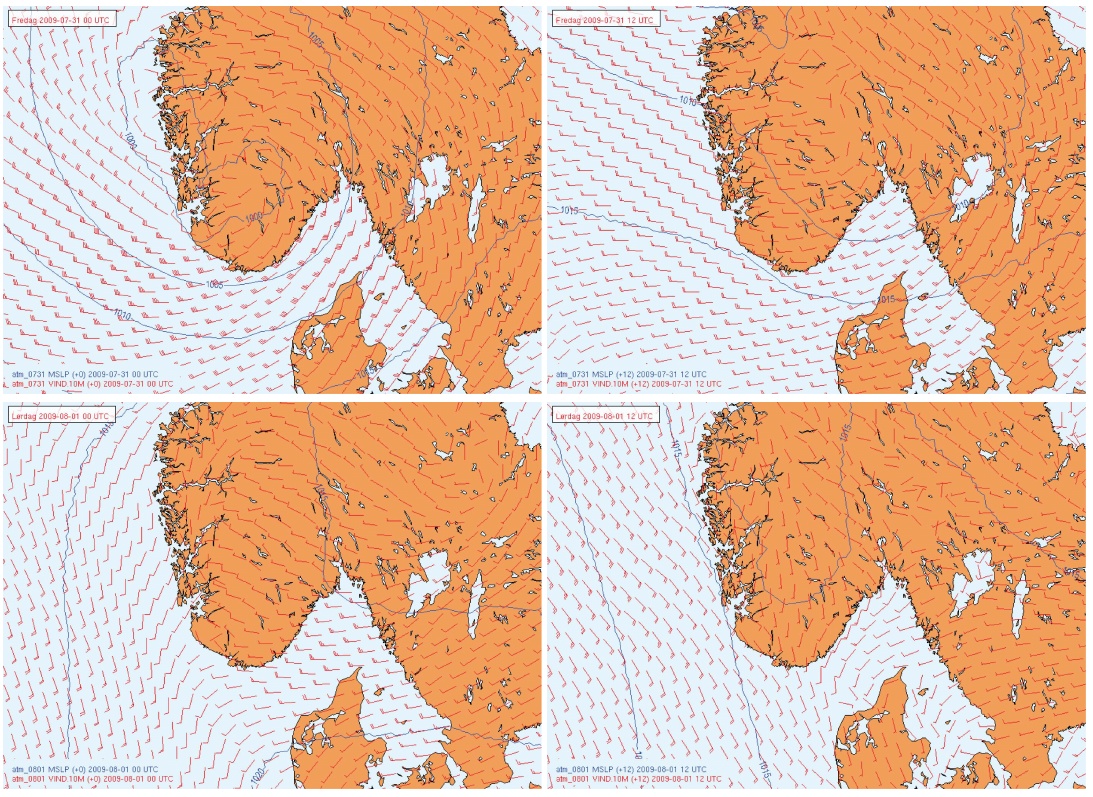
Fig. 2. The sea level pressure and the wind at the surface from met.no. The fields are from the operational HIRLAM model running with 8km resolution. Upper left panel is from 31 July at 00:00; upper right panel is from 31 July at 12:00; lower left panel is from 1 August at 00:00; and lower right panel is from 1 August at